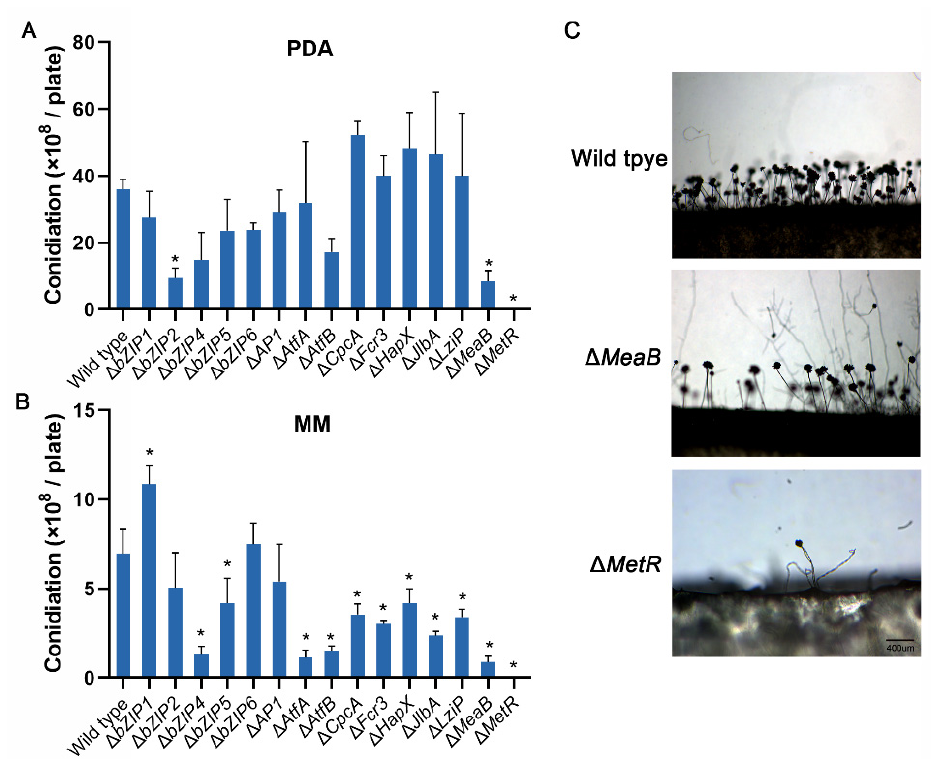
Figure 5. Analysis of conidial production of Aspergillus flavus strains. In total, 1 × 10 4 spores were cultured on PDA ( A ) and MM ( B ) media for 7 days at 30 °C. The conidia produced per plate by the tested strains were numbered. Error bars represent the SD. * p < 0.05, significant difference from the wild-type group as estimated by a Dunnett test. ( C ) Conidiophores of the mutant strains ∆ MeaB and ∆ MetR on PDA. Bar = 400 µ m. MM, minimal media; PDA, potato dextrose agar; SD, standard